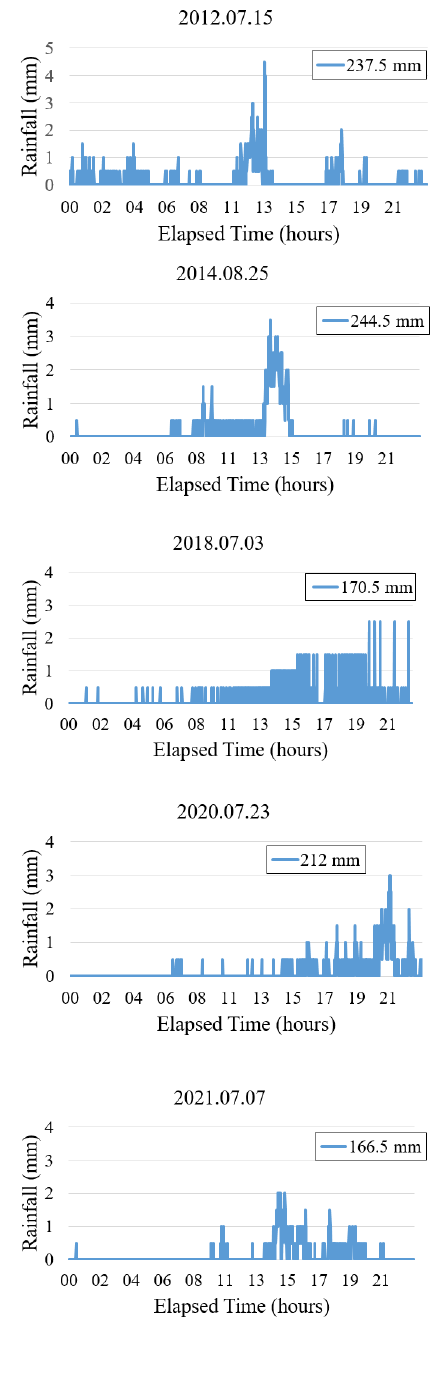
Table 2. Main Input Parameters of SWMM.